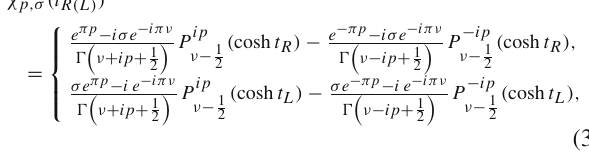
limit of ν = 1 / 2 (conformal) and ν = 3 / 2 (massless). At